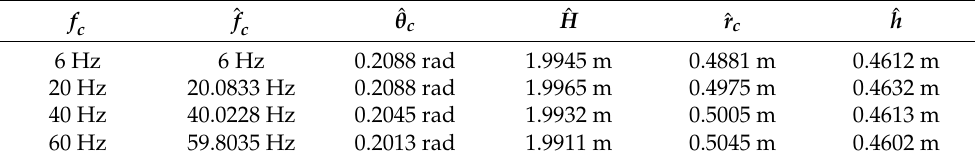
Table 3. The estimated values of the five parameters under different coning